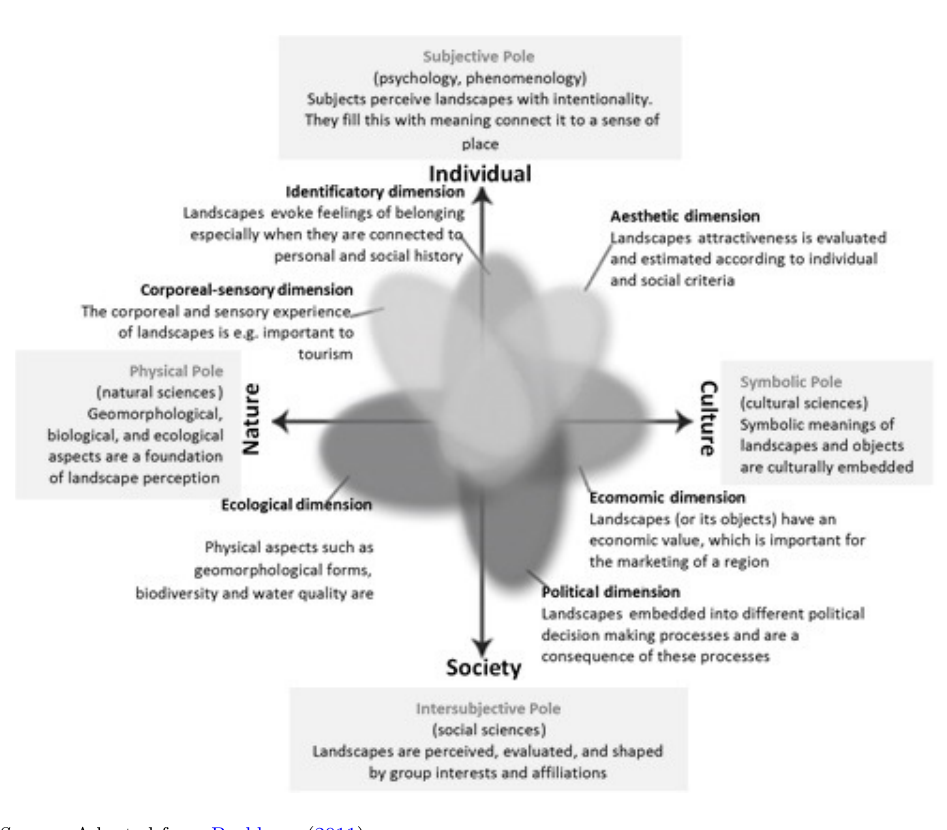
Figure 13: The four pole model with its six dimensions of landscape